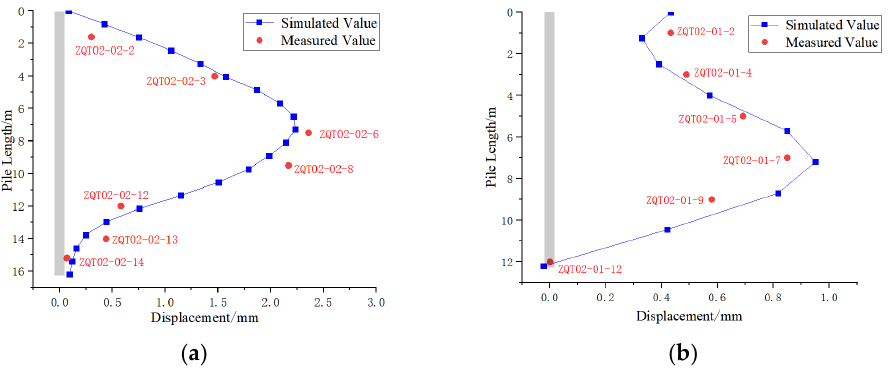
Figure 19. Comparison diagram of horizontal displacement of measuring points: ( a ) ZQT02-02; ( b ) ZQT02-01.